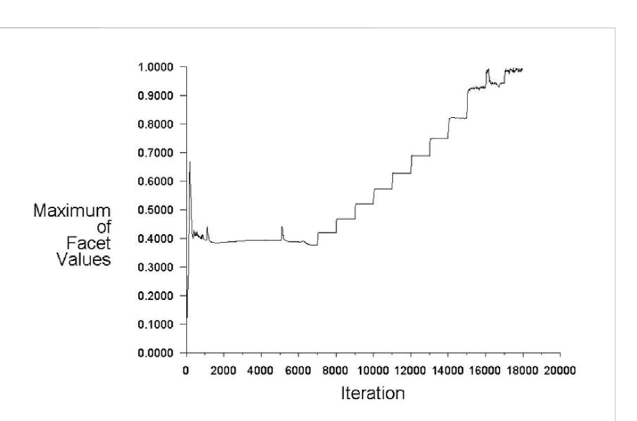
FIGURE 3 Maximum void fraction on the heated wall surface monitored.